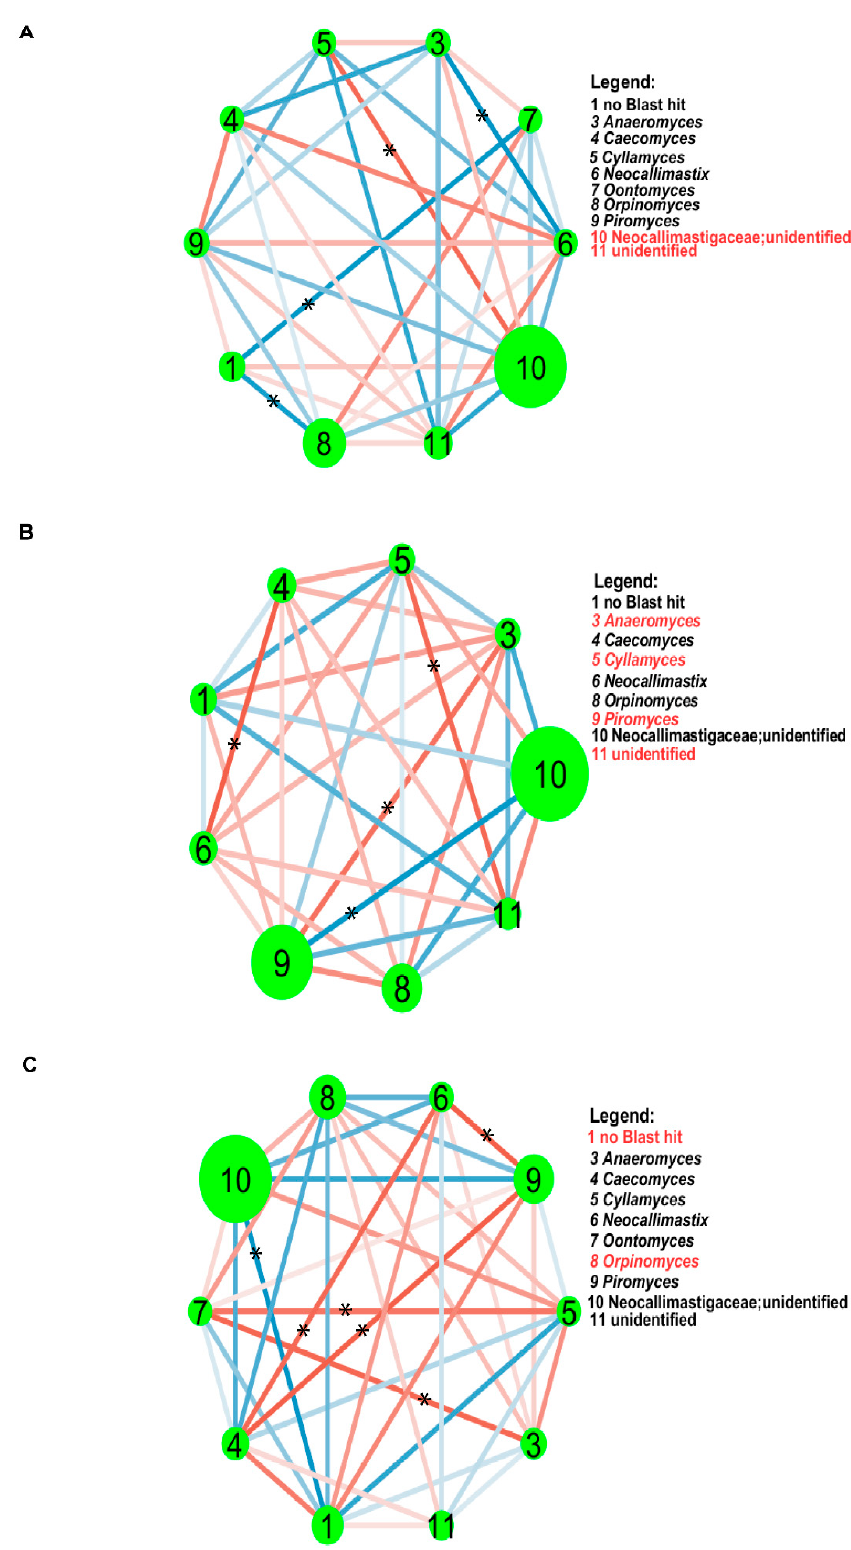
Figure 5. The co-occurrence network analysis of rumen fungi in yak ( A ), Tibetan sheep ( B ) and Small Tail Han sheep ( C ). The size of each node is proportional to the relative abundance. Line in red and line in blue denote positive and negative correlations, respectively. The keystone species were colored by red in the Legend. The correlations between nodes which reached statistically significant levels ( p < 0.05) were noted with an asterisk (*) in the